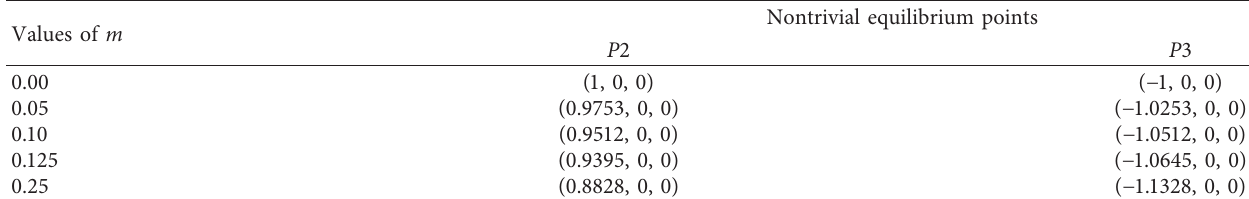
Table 2: Modifications of nontrivial equilibrium points for different values of m